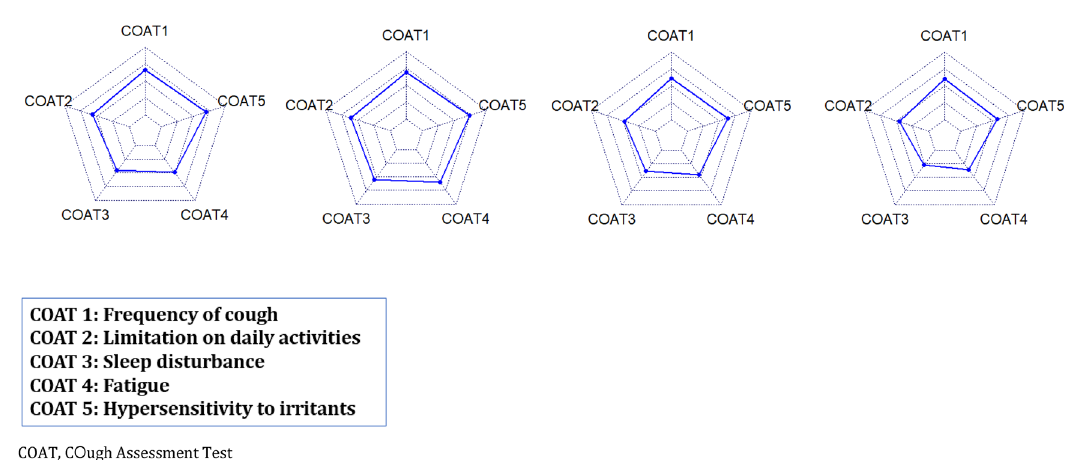
Figure 2. Comparison of score of each item of COAT among each cause of chronic cough. ( A ) Upper airway cough syndrome, ( B ) Asthma/Cough variant asthma, ( C ) Eosinophilic bronchitis, ( D ) Gastro-esophageal reflux disease. COAT COugh Assessment